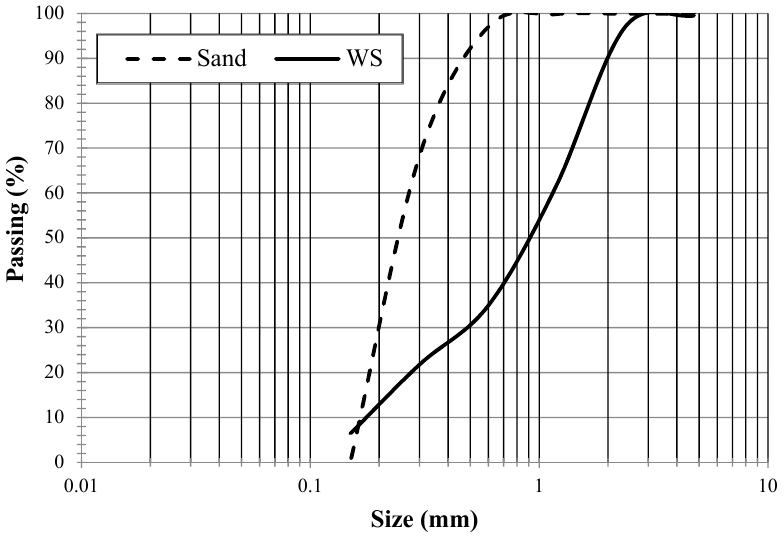
Figure 1. Gradation of sand and wood shavings.